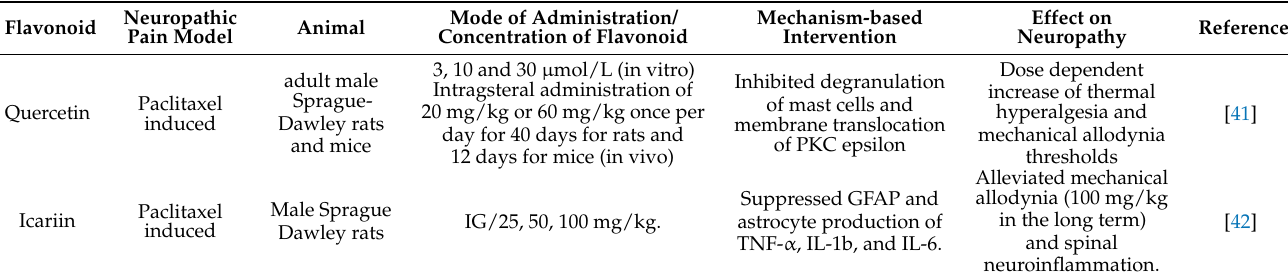
Table 6. Studies investigating the effects of flavonoids on CIPN